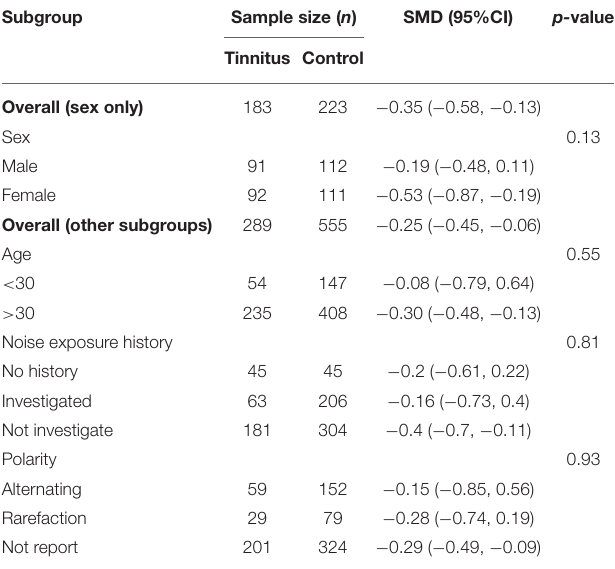
TABLE 4 | Subgroup analysis of the relationship (95% CI) between wave I amplitude and sex, age, noise exposure history and